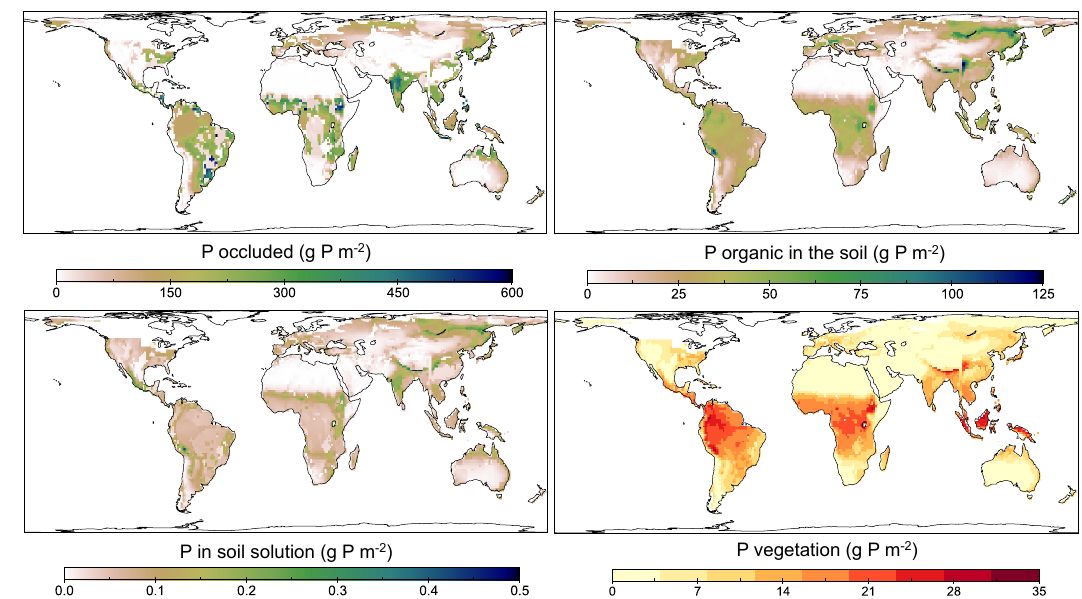
Figure 10. P pools in the soil considering active P vegetation uptake after 70000 simulated years of pedogenesis.